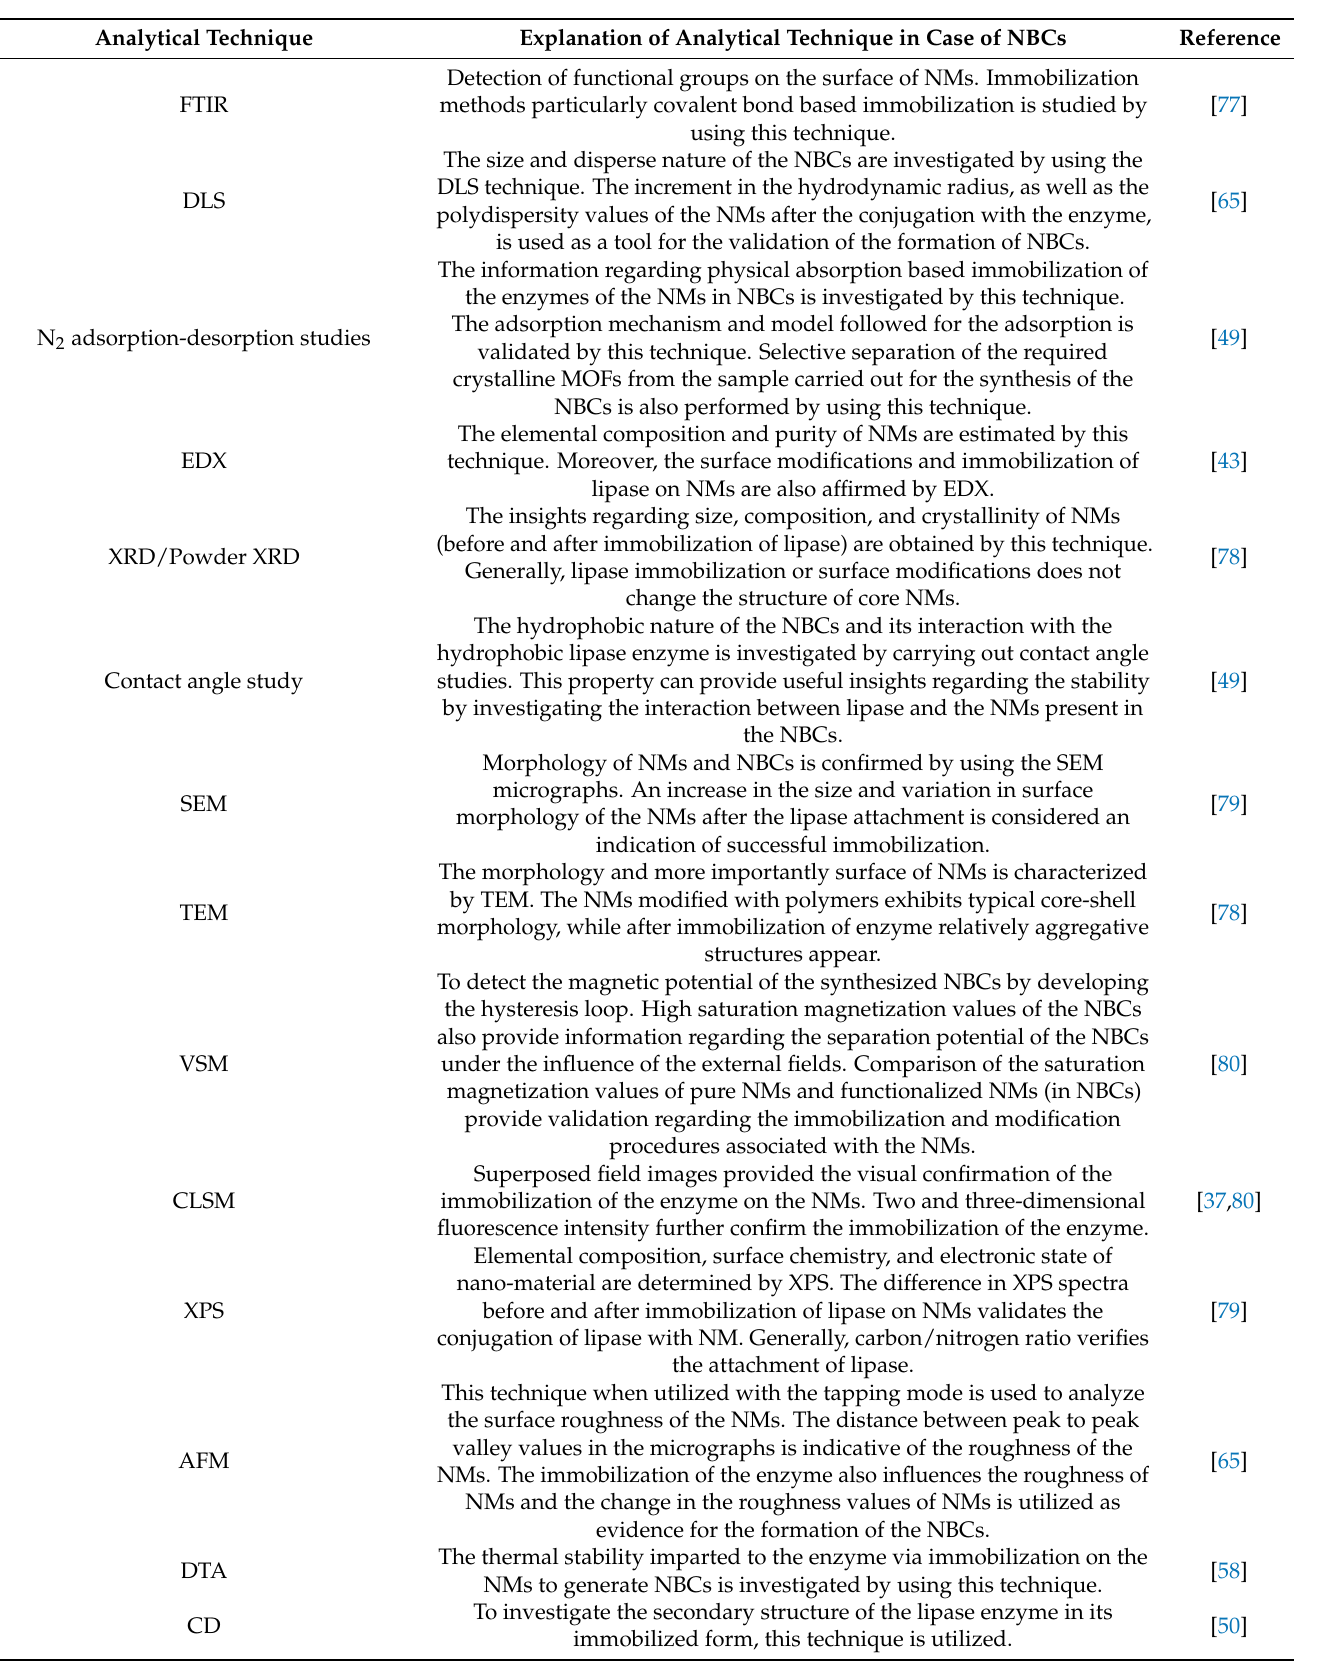
Table 3. Various analytical techniques utilized for characterization of